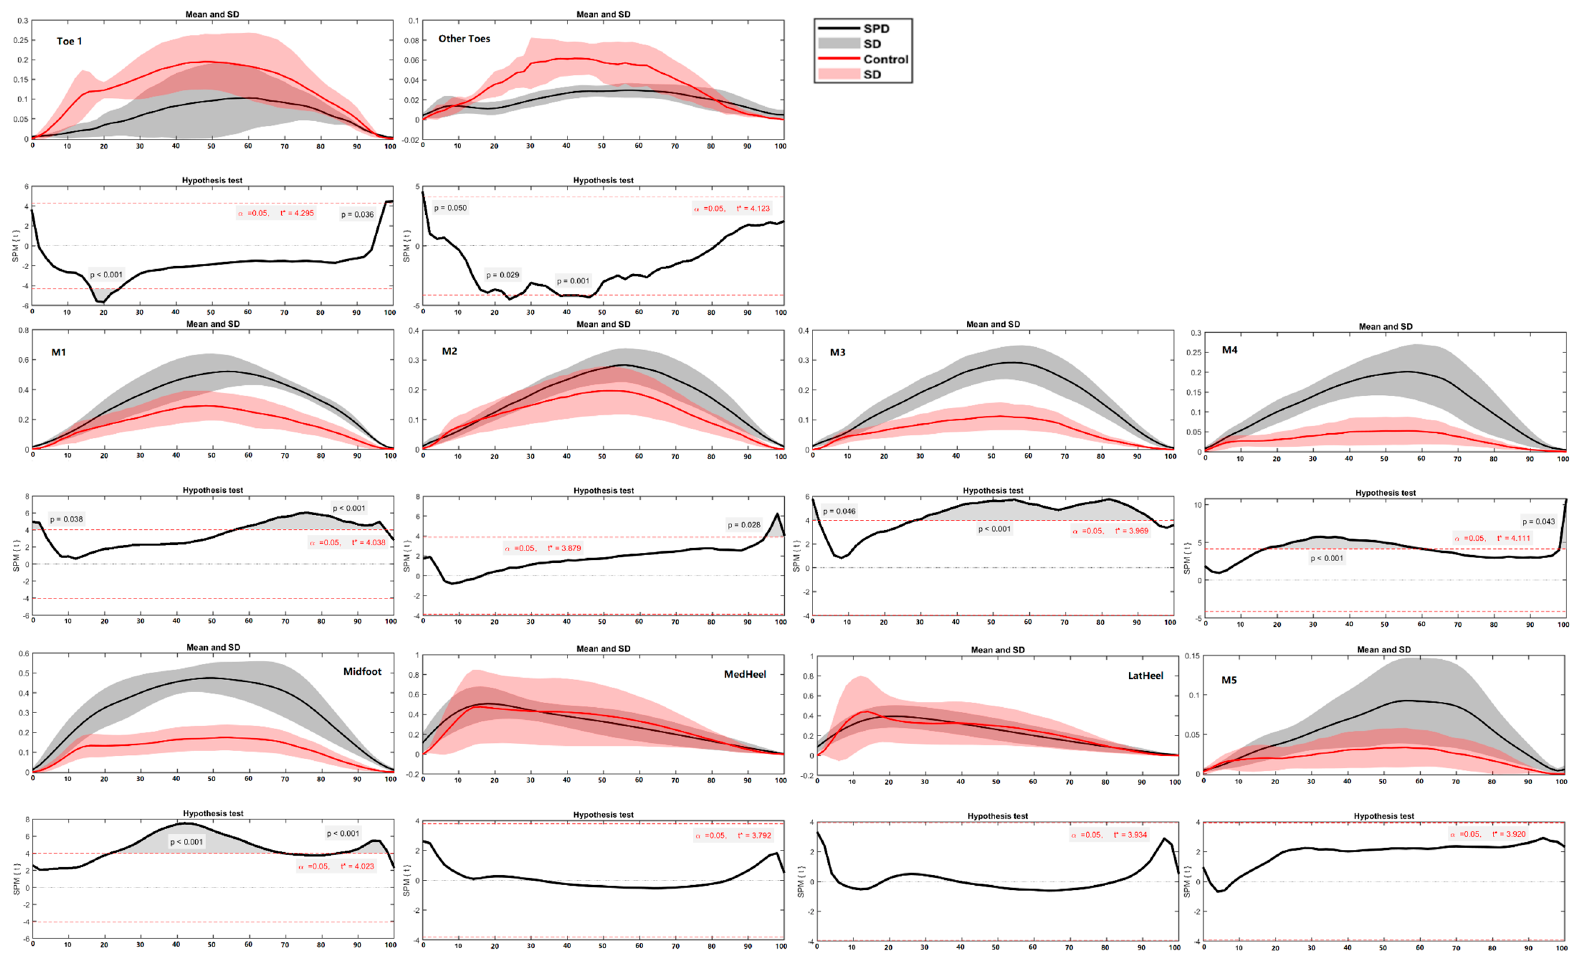
Figure 11. The regional plantar forces in the left foot during turning in the SPD children and healthy controls with highlighted statistics.